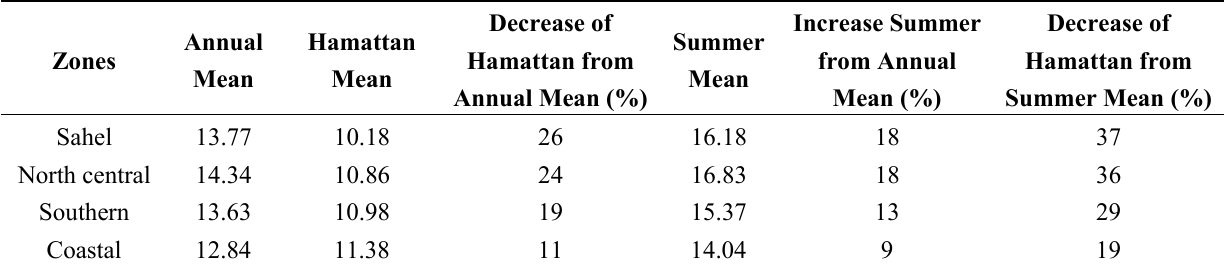
Table 1. Summary of 30-years annual and seasonal mean visibility and percentage change for Nigeria.